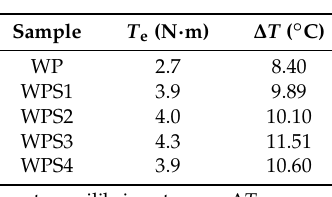
Figure 4. Curves depicting torque and temperature versus time of wood flour/PLA composites with different PLA- g -St/MAH loading rates. Table 2. Torque rheological parameters of the wood flour/PLA bio-composites with different PLA- g -St/MAH loading rates.